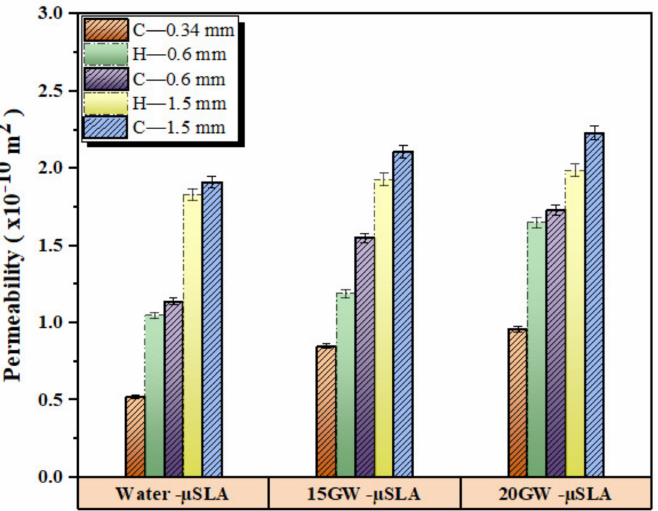
Figure 8. Experimentally measured permeability values for µ SLA 3D-printed scaffold structures using tap water, 15% glycerol–water solution, and 20% glycerol–water solution at 30% porosity for both scaffold structures with cubic and hexagonal pore shapes.